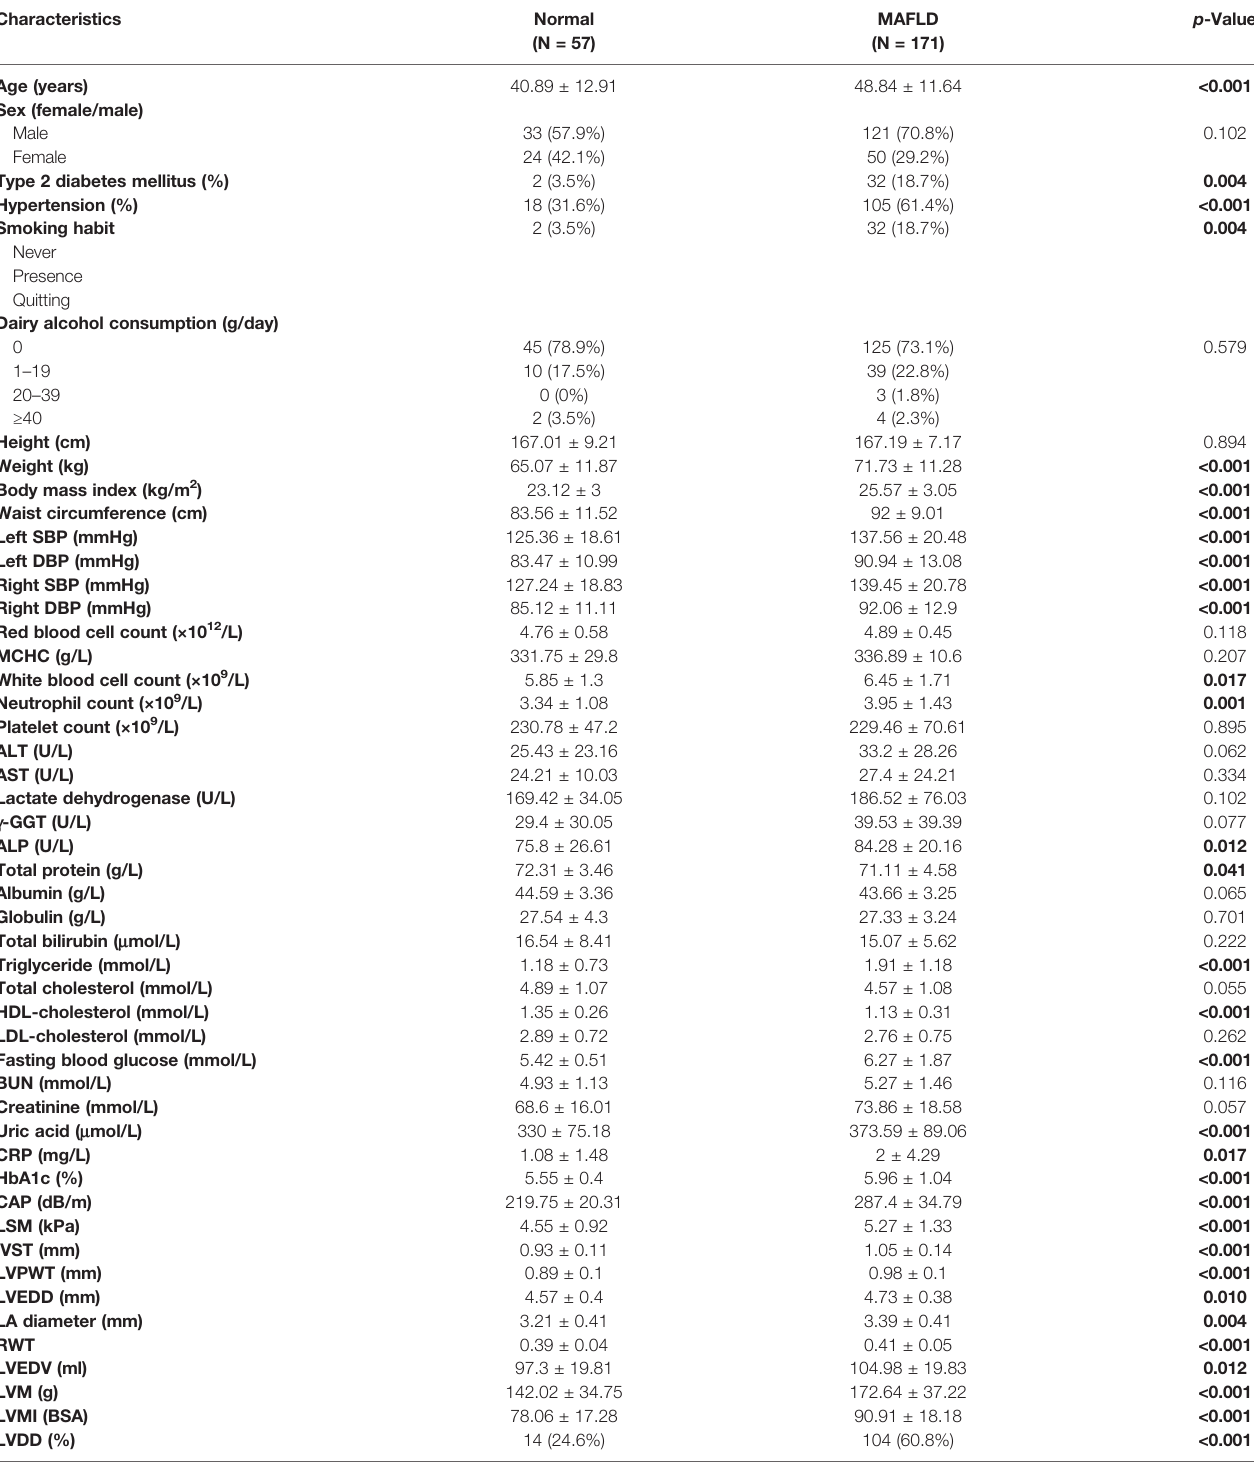
TABLE 2 | Characteristics of the study samples.